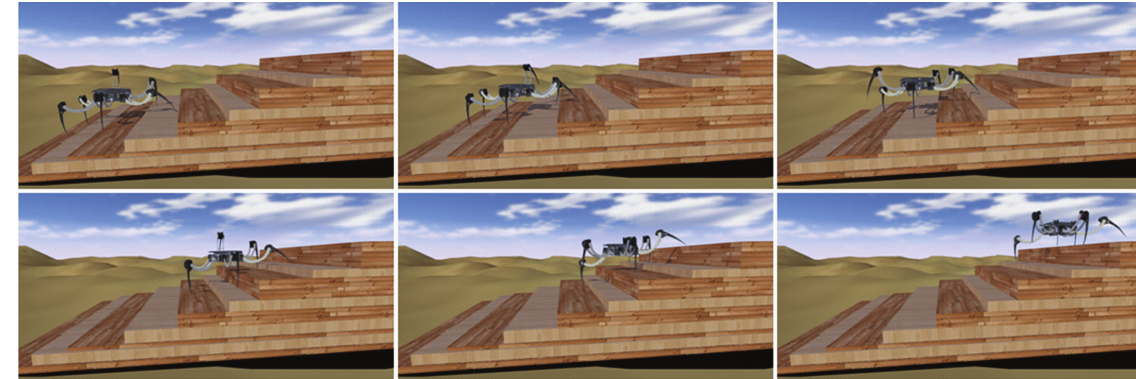
Figure 6: Pictorial representation of robot climbing steps of variable heights using Foothold Reflex Control (FRC)